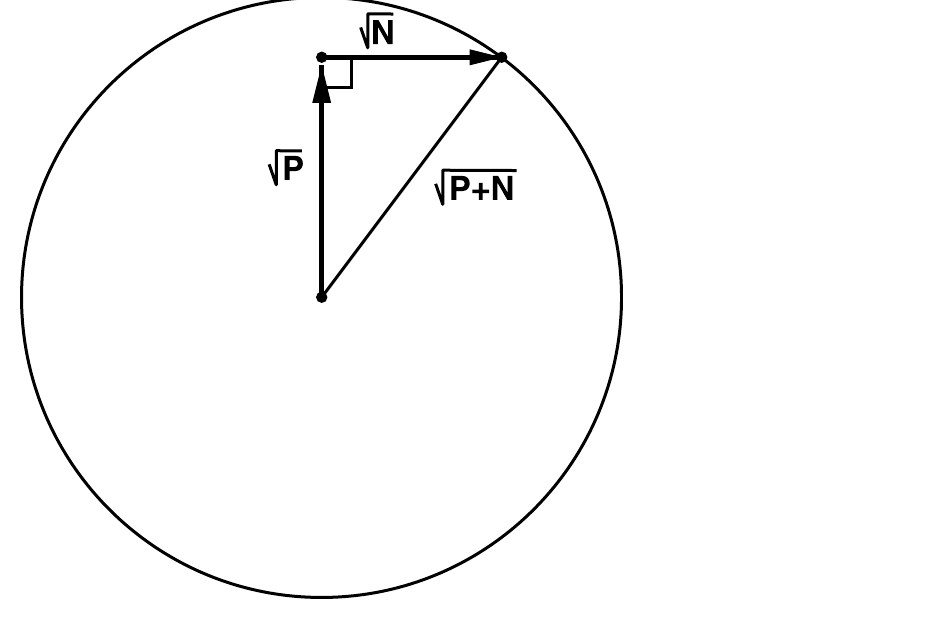
Fig 5. Geometry of hyperspace